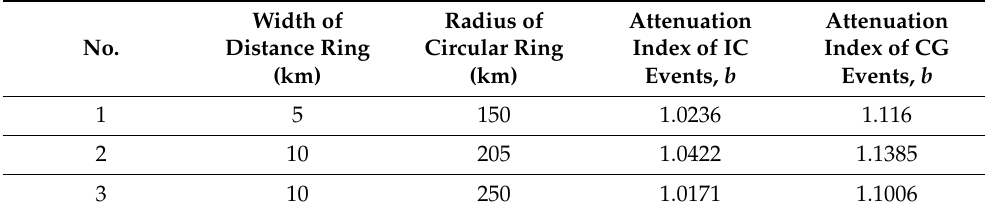
Table 1. Variation in the E -field peak values of CG and IC events with distance from the HF station. Attenuation Attenuation Radius of Width of Index of CG Index of IC Circular Ring No. Distance Ring Events, b Events, b (km) (km) 1 5 150 1.0236 1.116 2 10 205 1.0422 1.1385 250 1.0171